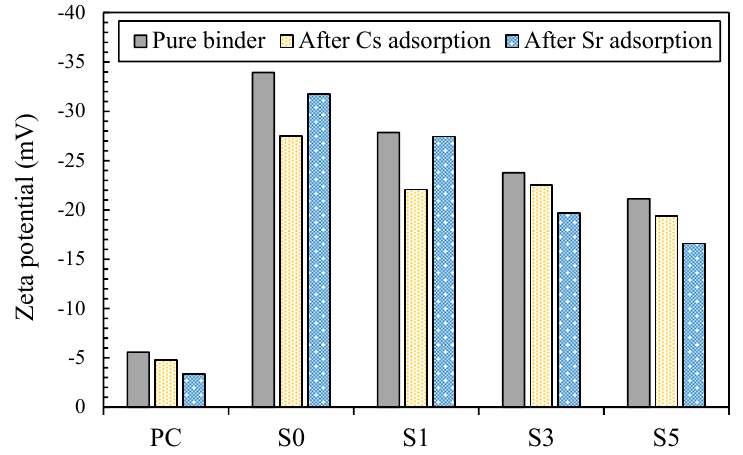
Figure 5. Zeta potential values of powdered binders before and after the adsorption tests.